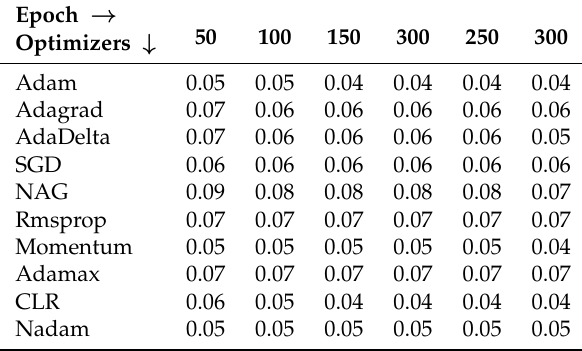
Table 7. Validation loss of ten optimizers on a proposed patch-wise model architecture of CNN.